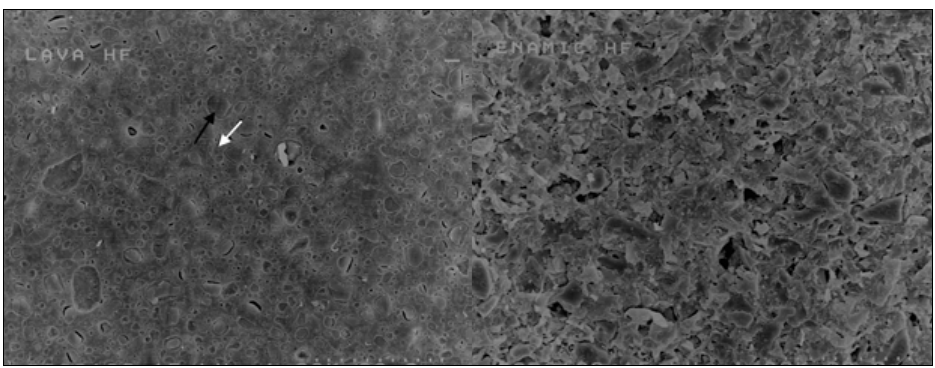
Figure 6. 9.6% Hydrofluoric acid etch. On left: Black arrow represents the polymer phase and the white arrow represents the ceramic